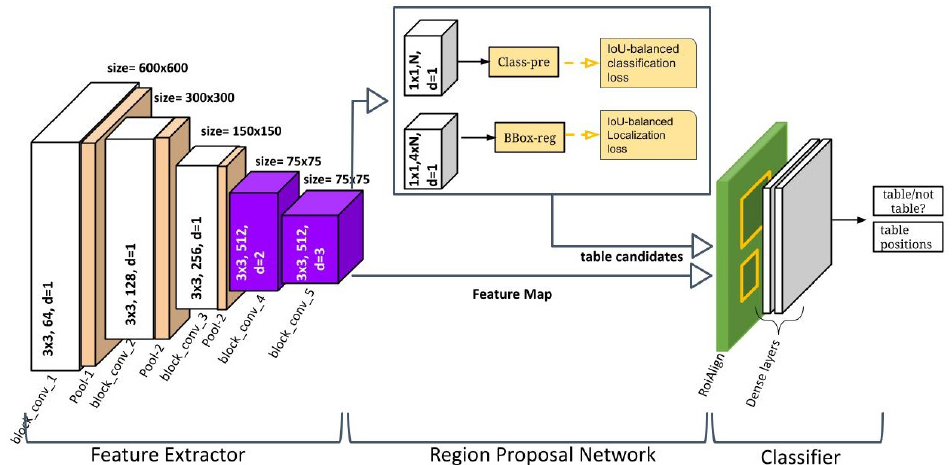
Figure 1. The DCTable architecture. In the first stage, the feature extractor is composed of strided convolutional layers in the three first blocks and where each one is followed by a pooling layer. The two other blocks are equipped with dilated convolutions where the used dilation rates are d = 2 and d = 3, respectively. Then, the RPN is trained with IoU -balanced loss. The final stage is composed of ROIALign layer and dense layers.